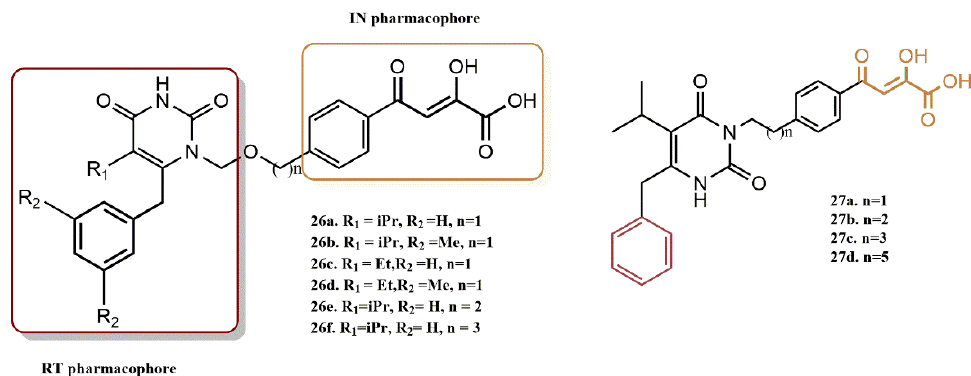
Figure 23. IN binding mode representation.